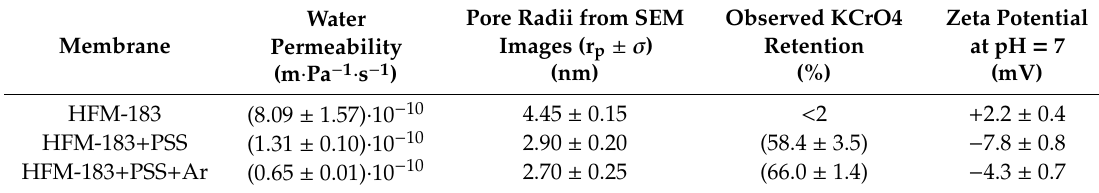
Table 1. Characteristics of the original and modified membranes